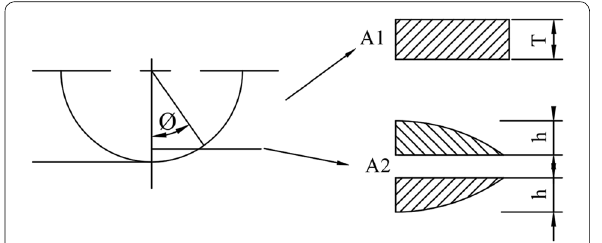
Figure 8 Area between the blade and the side of rock Figure 9 Area of side